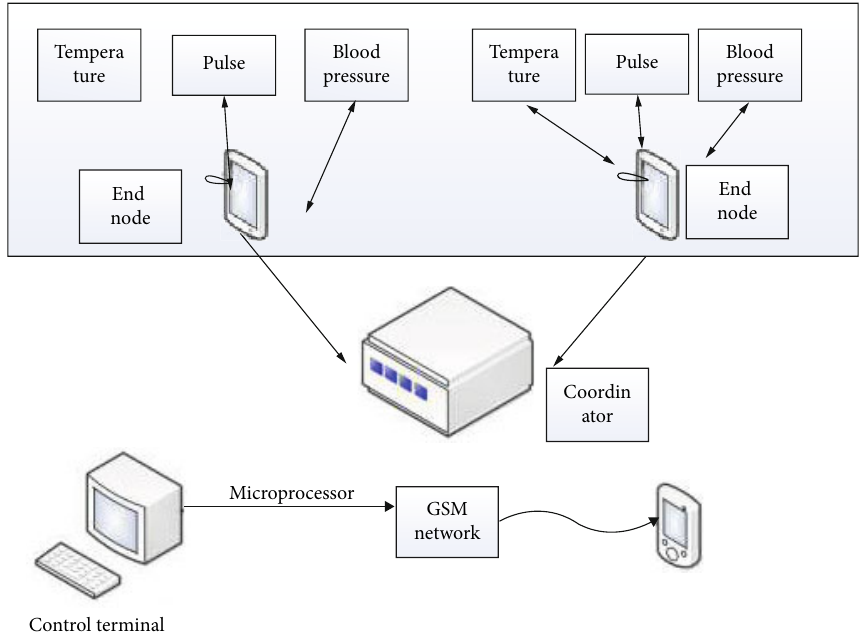
Figure 1: Intelligent health monitoring